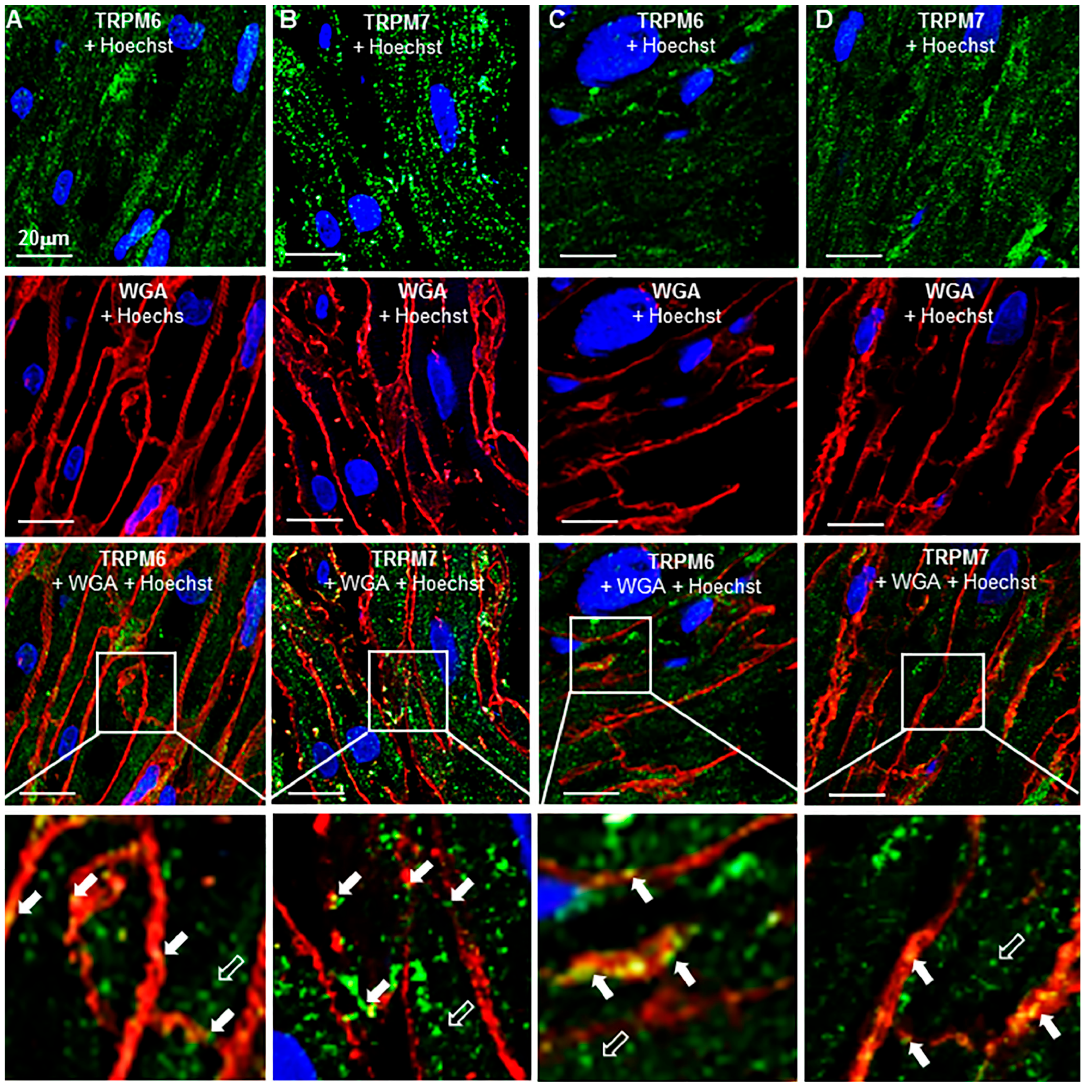
Figure 7. TRPM6 and TRPM7 detection by immunohistochemistry in diseased human RA tissue: ( A – D ) Representative images obtained from longitudinal slices of RA tissues from two different patients: an ischemic heart disease (IHD) patient ( A , B ) and an AF patient ( C , D ). The area labeled with the square bars corresponds to the images presented on a larger scale in the panels below them. AF-488 for the TRPM6 and TRPM7 protein appears in green. AF-555 for the cell membrane surface labeling with WGA appear in red, and Hoechst 33342 for the nucleus staining appear in blue. Arrows highlight the presence of TRP proteins. Notice, qualitatively, the amorphous distribution of TRPs and less colocalization with the cell membrane in both the IHD ( A , B ) and AF ( C , D ) hearts as compared with the control (car victim’s heart in Figure